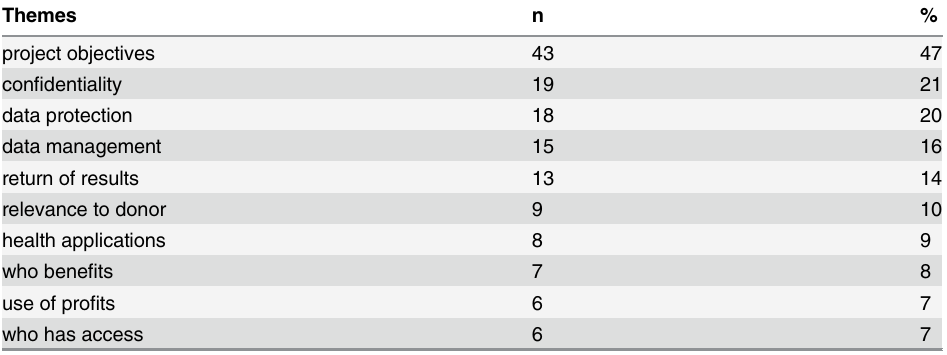
Table 4. Top 10 Themes in Respondents ’ Desired Information about Biobank